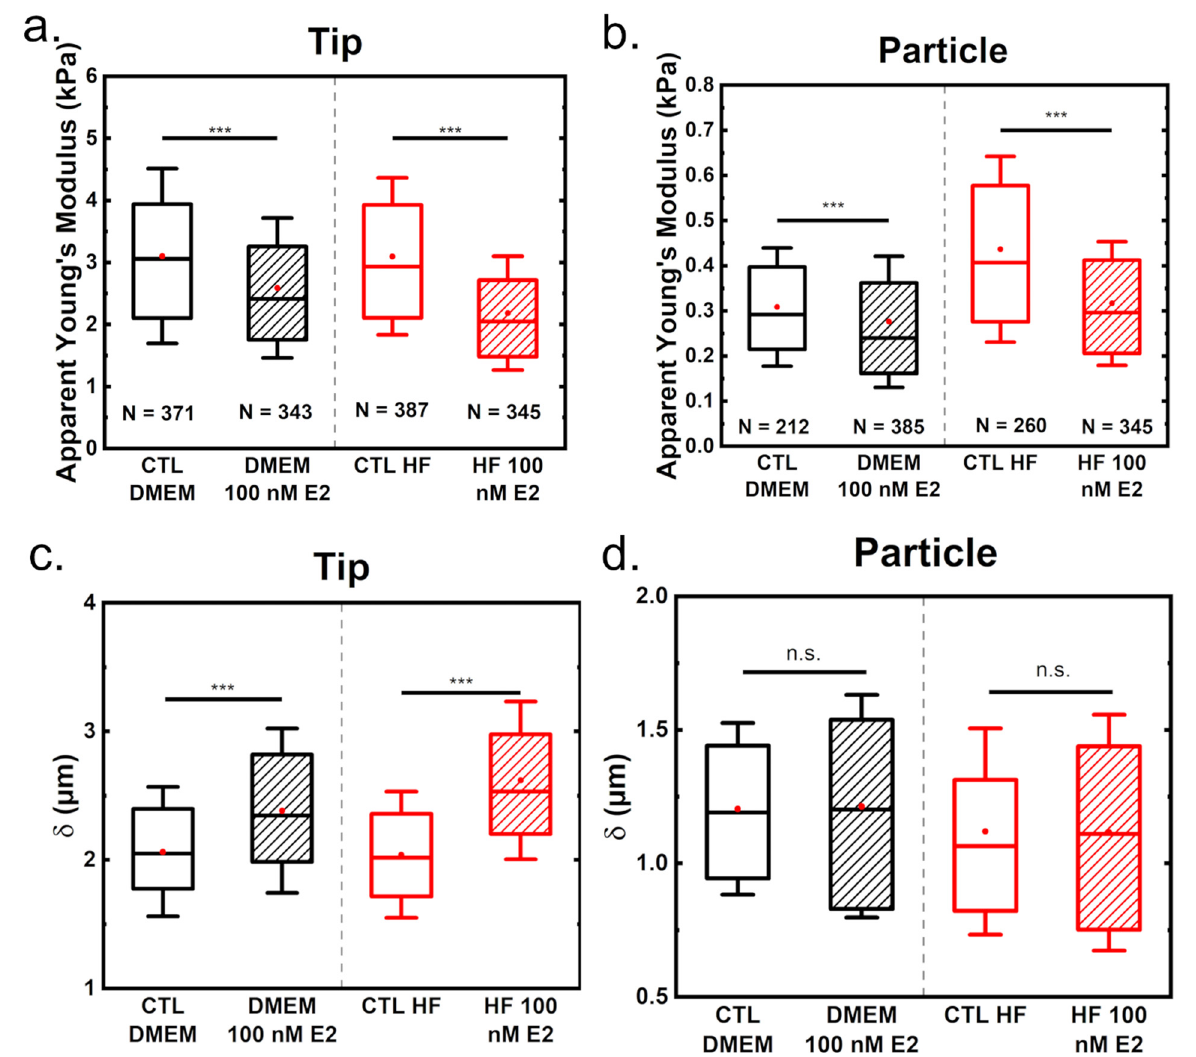
Figure 2. Influence of estrogen on the mechanical properties (apparent Young’s modulus for tips in ( a ) and particles in ( b ), and indentations at a force of 2 nN in ( c ) for tips and ( d ) for particles) for measurements performed with either tips or particles. An indentation depth of 500 nm was evaluated for Young’s modulus determination. N indicates the number of measurements considered. The boxplots indicate the data from the 25th to the 75th quantile, with the whisker being 1× the standard deviation, the red dot the mean value and the line in the middle the median. Statistical significances are reported as *** for p < 0.001.